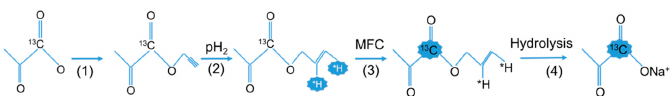
Figure 3. Diagram of the para -hydrogen-induced hyperpolarization side-arm hydrogenation (PHIP-SAH) procedure. (1) Functionalization of the carboxylate group with the side-arm; (2) para -hydrogenation of the unsaturated alcohol; (3) transfer of para -hydrogen spin order to the 13 C spin of the carboxylate group; (4) cleavage of the side-arm. The yellow background indicates reaction steps taking place in the organic phase, while the blue background indicates that the molecule is dissolved in the aqueous phase. This figure was adopted according to Reference [98]. 5. In-Cell NMR and Posttranslational Phosphorylation